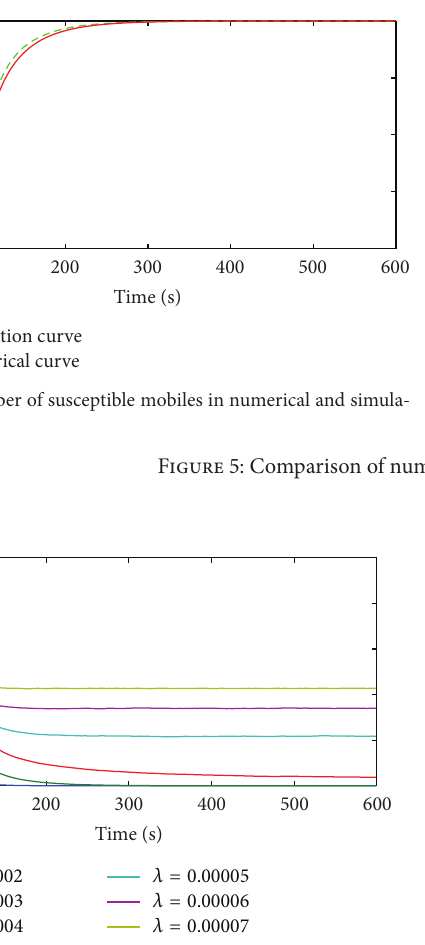
Figure 6: Impact of thecontact infection rate 𝜆 on theM-SIS model.